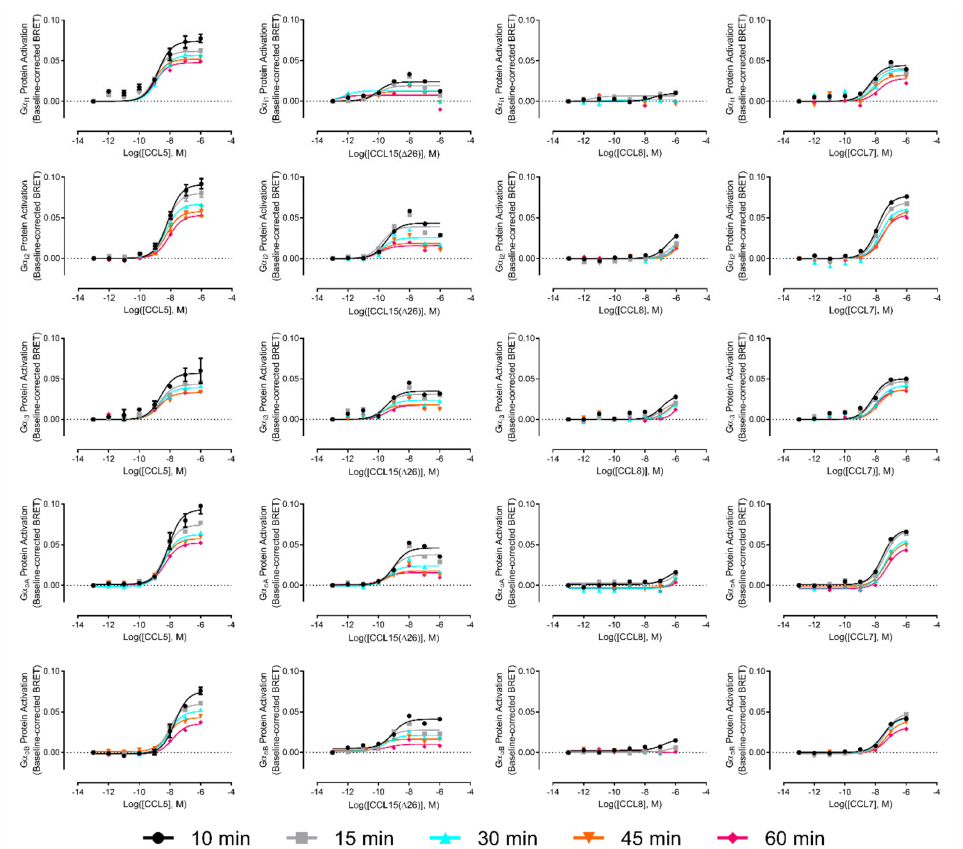
Figure A3. G protein activation concentration-response curves and time courses. Each graph shows the concentration-response data for a di ff erent chemokine and a di ff erent G α protein. Each column shows a di ff erent chemokine: (left to right) CCL5, CCL15( ∆ 26), CCL7, and CCL8 from. Each row shows a di ff erent G α protein: (top to bottom) i1, i2, i3, oA, and oB from. Data points represent means ± SEM of at least three independent experiments performed in duplicate.